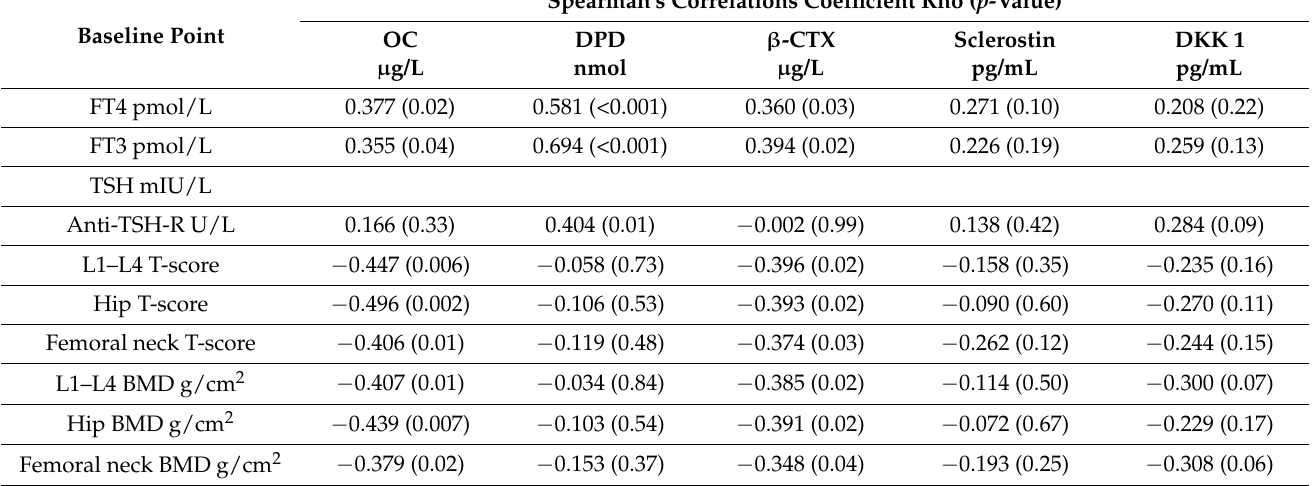
Table 6. Association of thyroid hormones, TSH, anti-TSH-R, and DXA findings with markers of bone turnover and Wnt inhibitors at baseline.